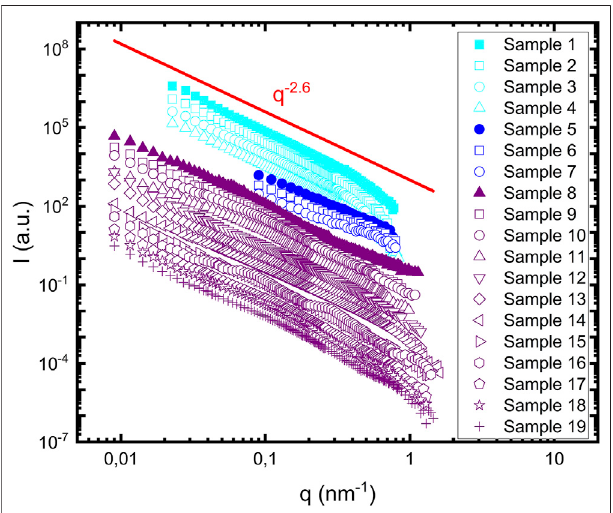
FIGURE 1 | Scattering pro fi les of 19 samples summarized in Table 1 . Samples containing lipids are represented with open symbols. Samples 1 – 4 are shown in cyan , samples fi ve to seven are shown in blue and samples 8 – 19 are shown in purple . Samples containing protein alone are represented with fi lled symbols. The red line represents the power law dependence of the scattering pro fi le, with a power value equal to